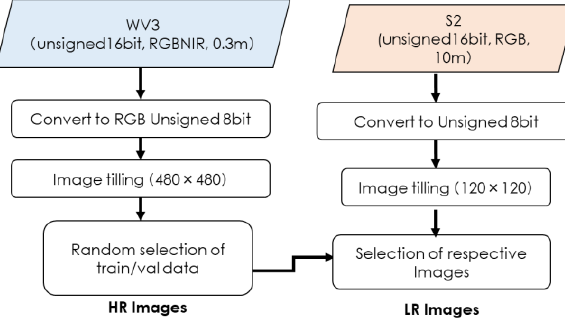
Figure 7 . Overview of dataset preparation for